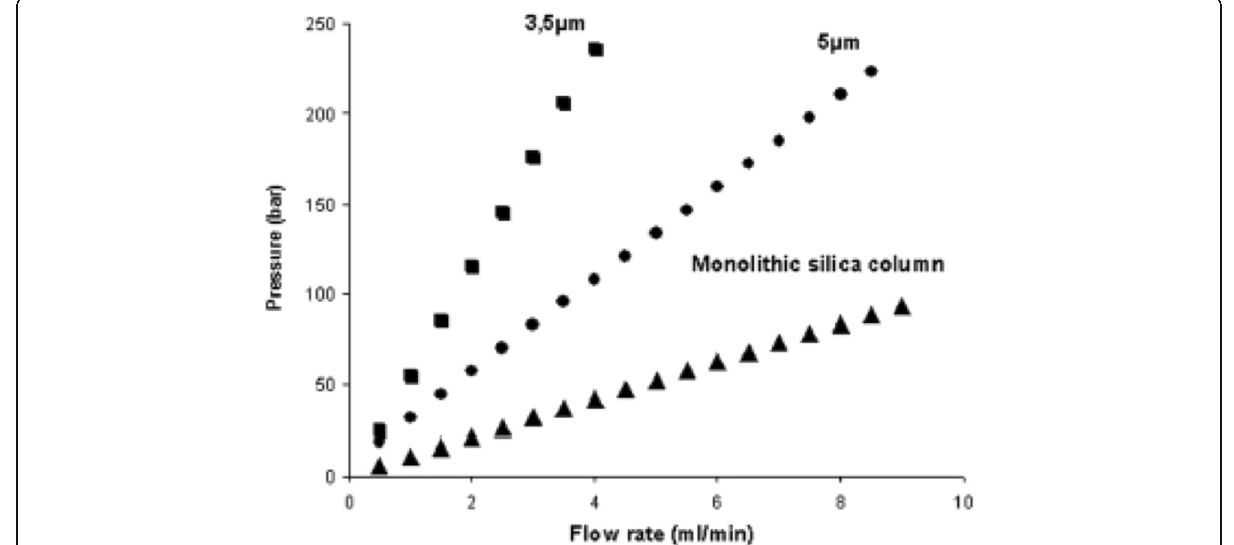
Fig. 2 Back pressure of conventional and monolithic silica column. (Cabrera, 2004)